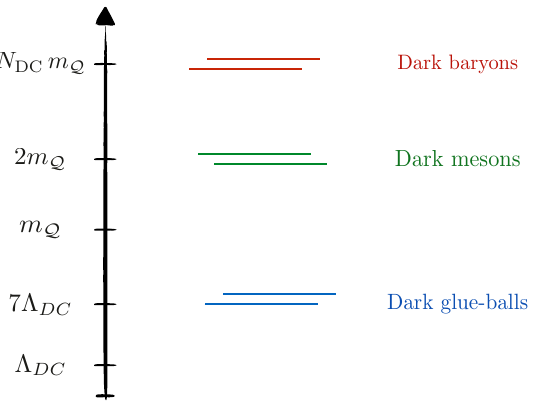
Figure 1 . Typical spectrum of the theory. We assume that the lightest dark quark is heavier than the dark con(cid:12)nement scale, (cid:3) DC . DM is dark baryon made of N DC dark quarks. The lightest dark states are unstable dark